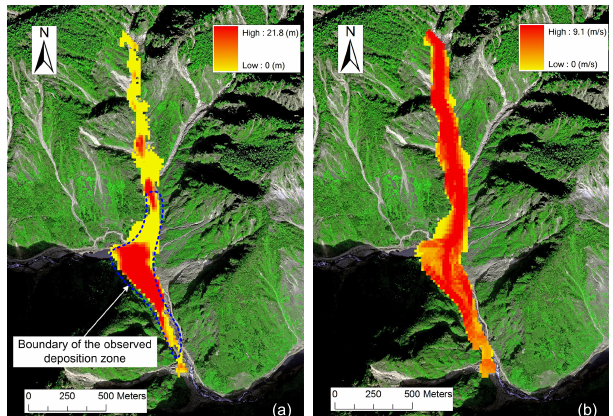
Figure 18. Simulation results of the Xiaojiagou debris flow: (a) fi- nal shape and depth of the deposition zone, (b) the maximum flow